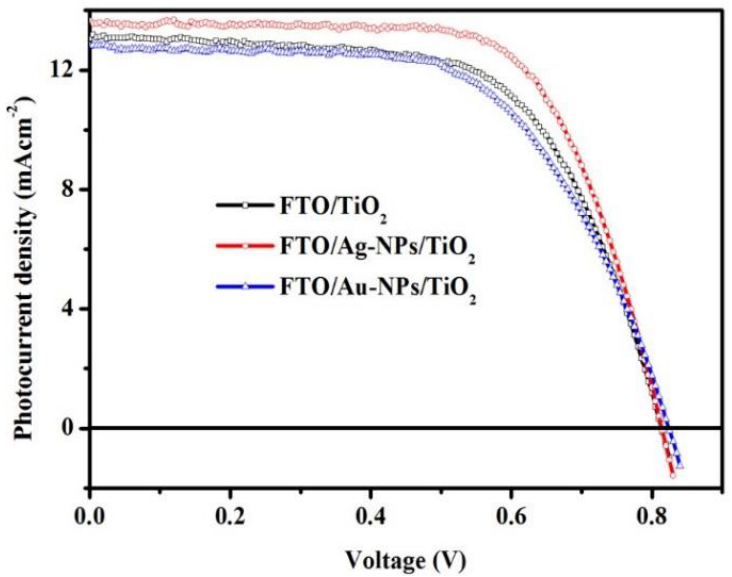
Figure 2. Current-voltage characteristics of three dye-sensitized solar cells (DSCs) equipped with different working electrodes. Table 1. Photoelectric performance of the three cells shown in Figure 2. J sc : The short-circuit current; V oc : the open-circuit voltages; FF: Fill Factor; η: efficiency; FTO: fluorine-doped tin oxide ; NPs: nanoparticles .